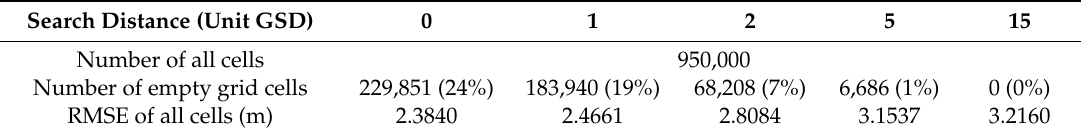
Table 1. The accuracy of the inverse distance weight (IDW)-based digital surface model (DSM) with search distance adjustment. GSD—ground sampling distance; RMSE—root mean square error.